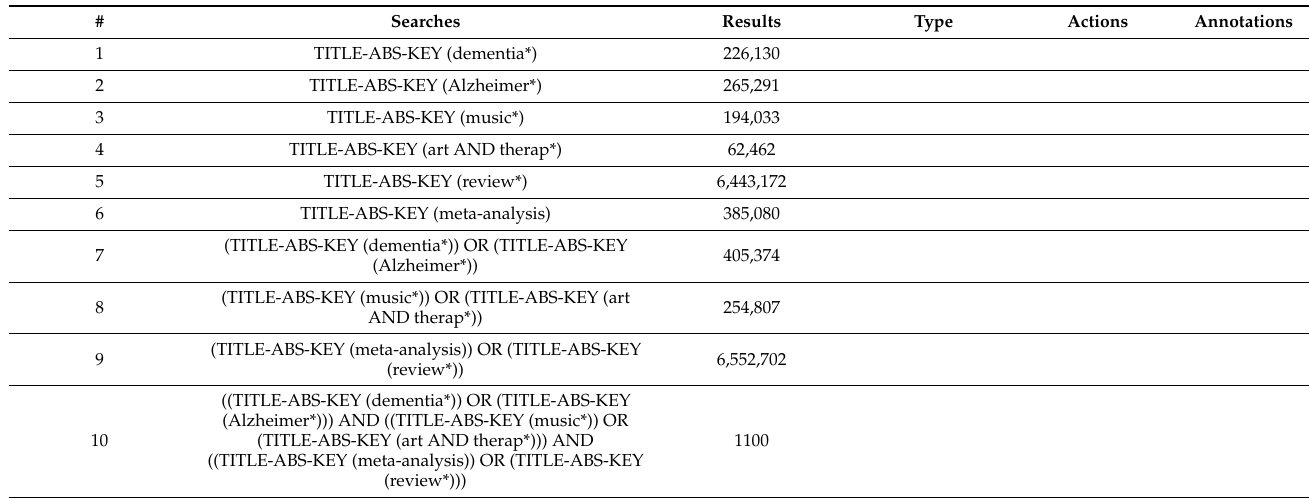
Table A4. SCOPUS—11 January